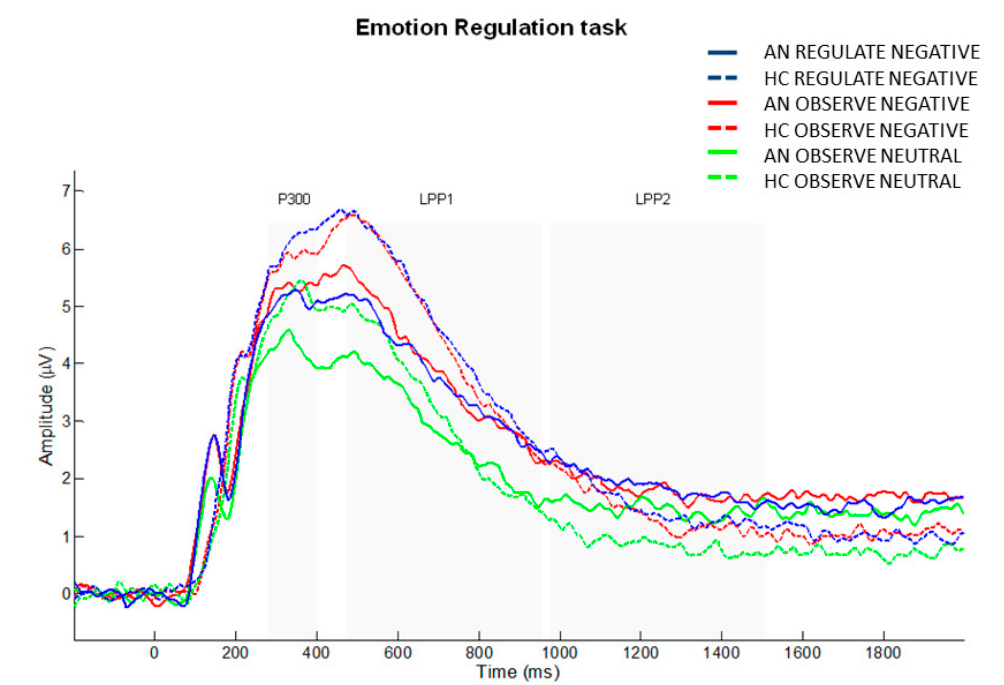
Figure 1. Grand average waveforms of the ER task, for each experimental condition (Regulate Negative, Observe Negative, Observe Neutral) and group (HC, AN), in the centro-parietal cluster of